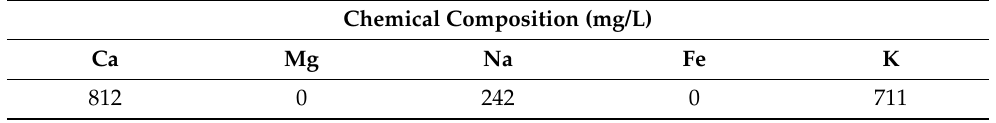
Figure 3. Concrete slurry water collection process. Table 2. Chemical composition of supernatant water (obtained by ICP